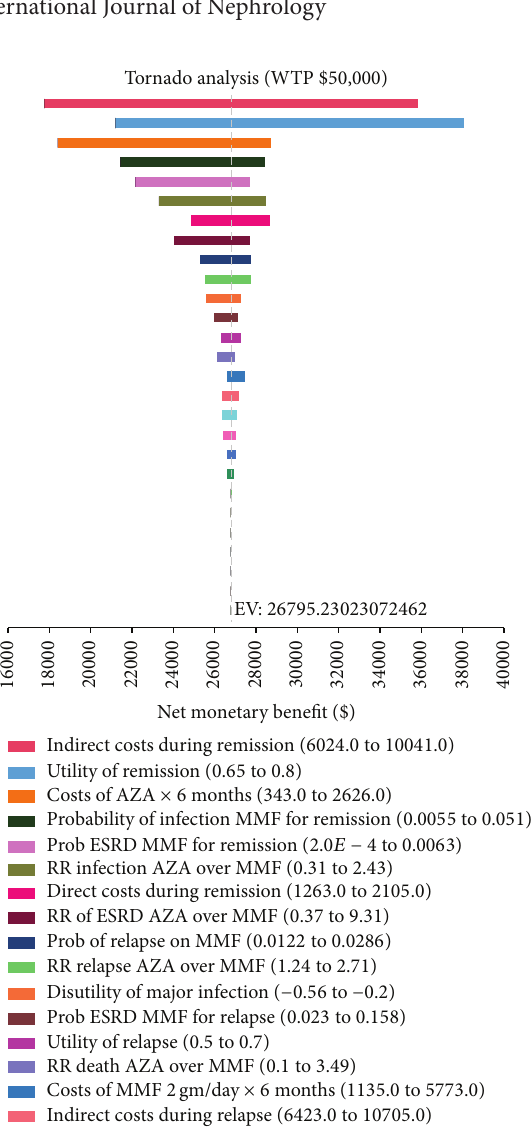
Figure 2: Tornado diagram of the 3-year base-case model, demon- strating one-way sensitivity analysis of each variable in the model. Each bar represents a range of expected values (EV), expressed as net monetary benefit in US dollars, over plausible estimates for an individual variable. The dotted vertical line indicates the base-case expected value. WTP: